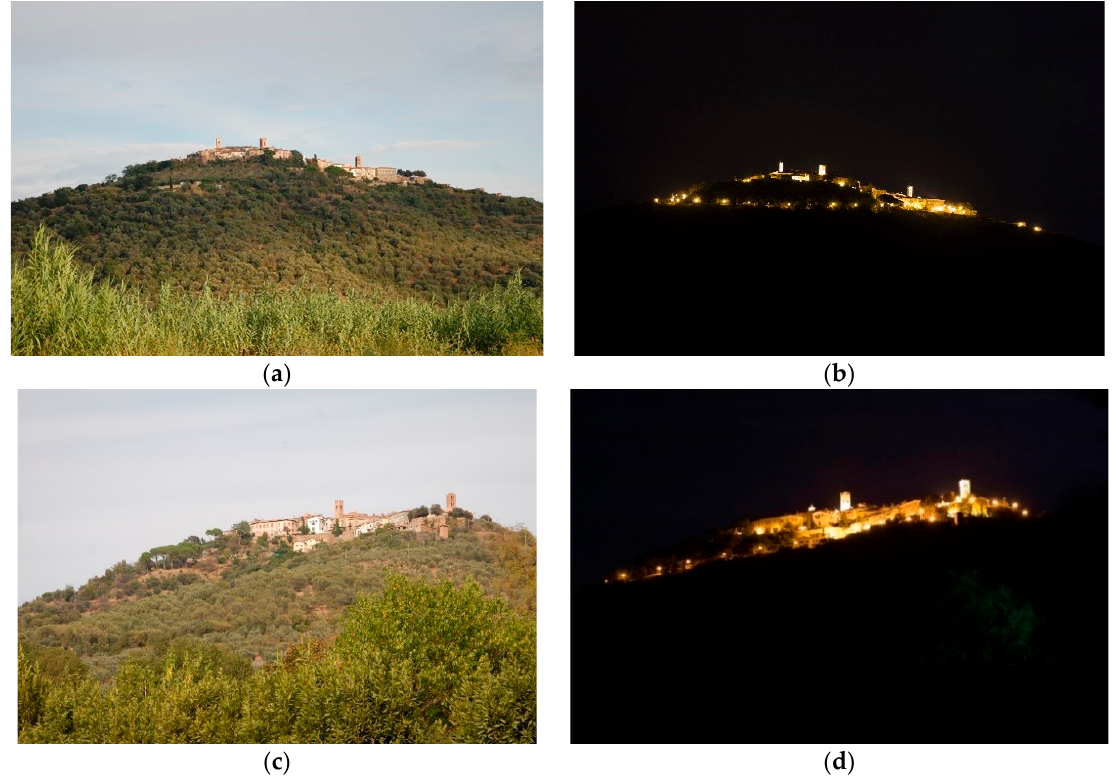
Figure 5. ( a ) day and ( b ) night photographs taken from the external point of view E1. ( c ) day and ( d ) night photographs taken from the external point of view E2. (Credits: Francesca Floris).